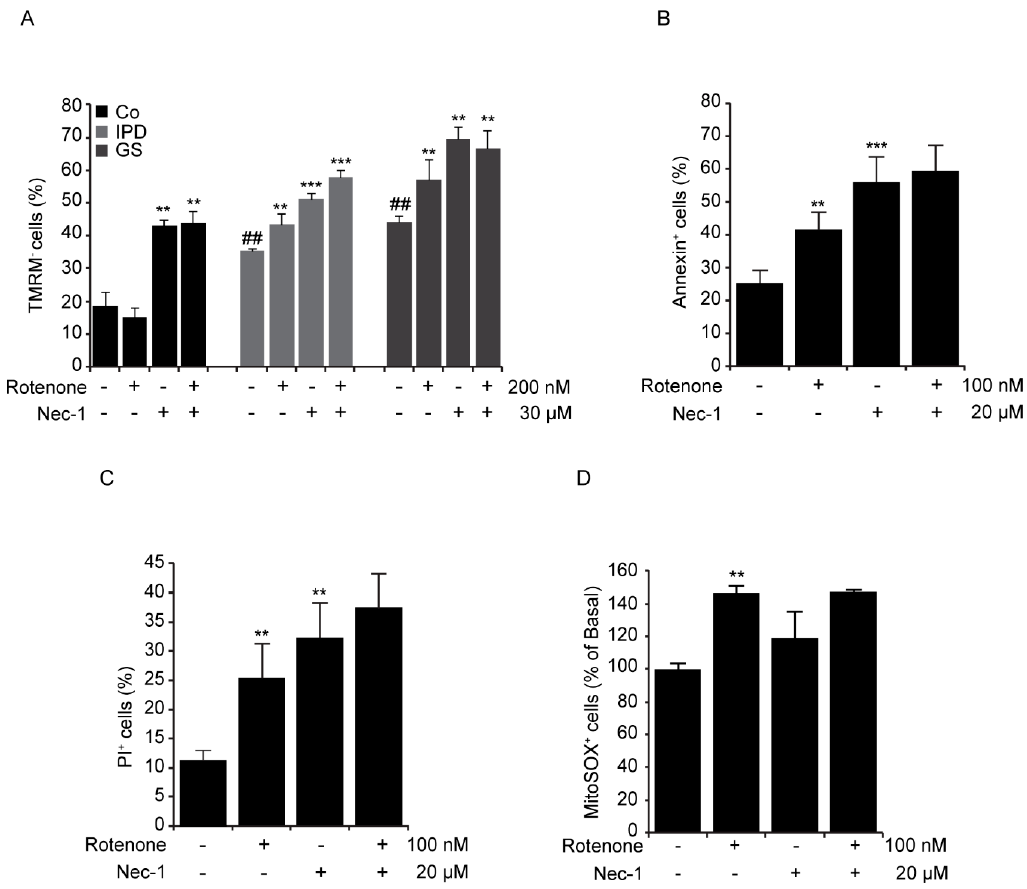
Figure 3. Rotenone-induced necroptosis in PD patients. ( A – D ) Cells were treated with rotenone and/or necrostatin-1 (Nec-1) for 24 h. ( A ) Cells were loaded with 50 nM tetramethylrhodamine, methyl ester, perchlorate (TMRM). The results represent the percentage ± SD of TMRM-negative cells detected by flow cytometry (** p < 0.01, *** p < 0.001 in comparison with basal conditions; ## p < 0.01 in comparison to Co line), n = 10,000 events. ( B , C ) SH-SY5Y cells were costained with annexin-FITC and propidium iodide (PI). The results represent the percentage ± SD of annexin + or PI + cells detected by flow cytometry (** p < 0.01, *** p < 0.001 compared to basal conditions), n = 10,000 events. ( D ) SH-SY5Y cells were loaded with MitoSOX (2 µM). The results represent the percentage ± SD of MitoSOX + cells detected by flow cytometry (** p < 0.01, compared to basal conditions), n = 10,000 events. Experiments were done three